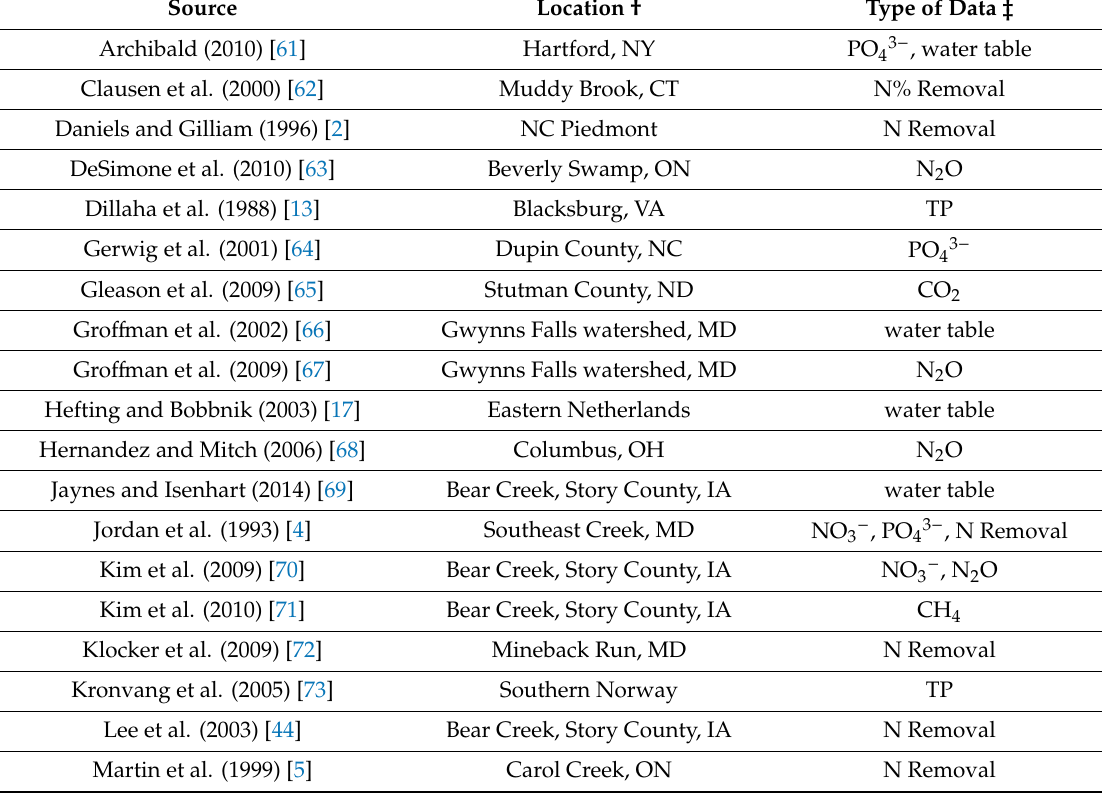
Table 3. Summary of studies used to obtain data for the validation of the individual models included in the RZ-TRADEOFF water and air quality